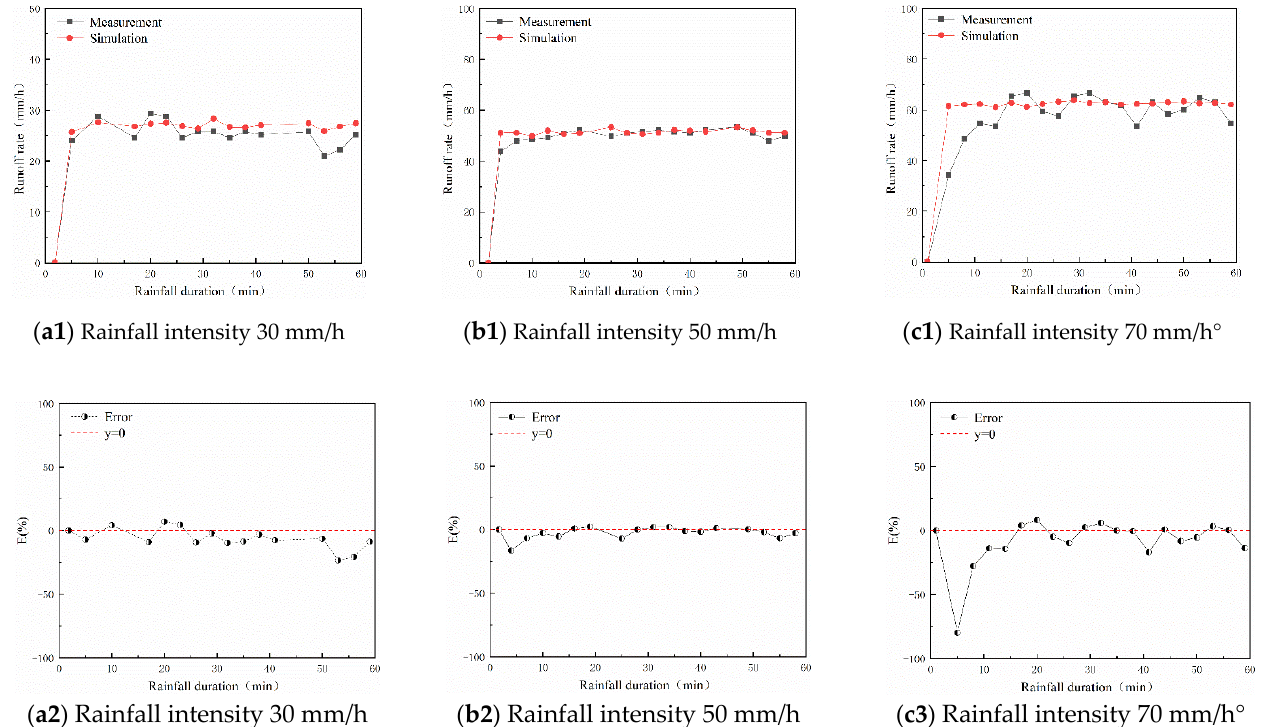
Figure 9. Comparison between measured and simulated runoff rates under different rainfall intensities.